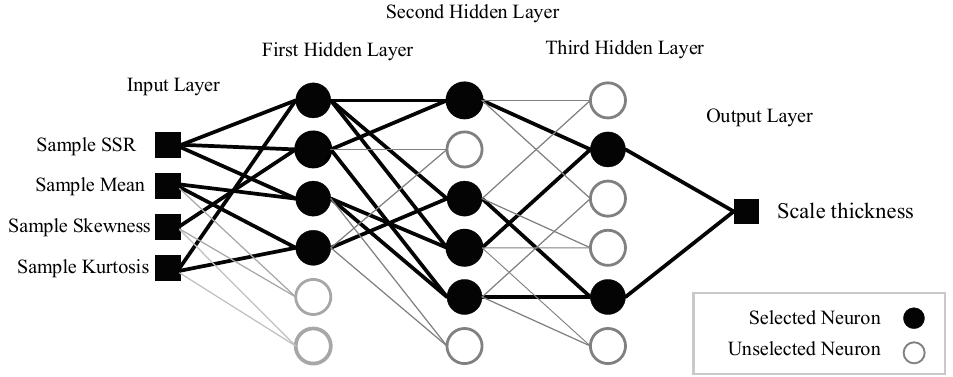
Figure 4. The structure of the trained GMDH neural network.